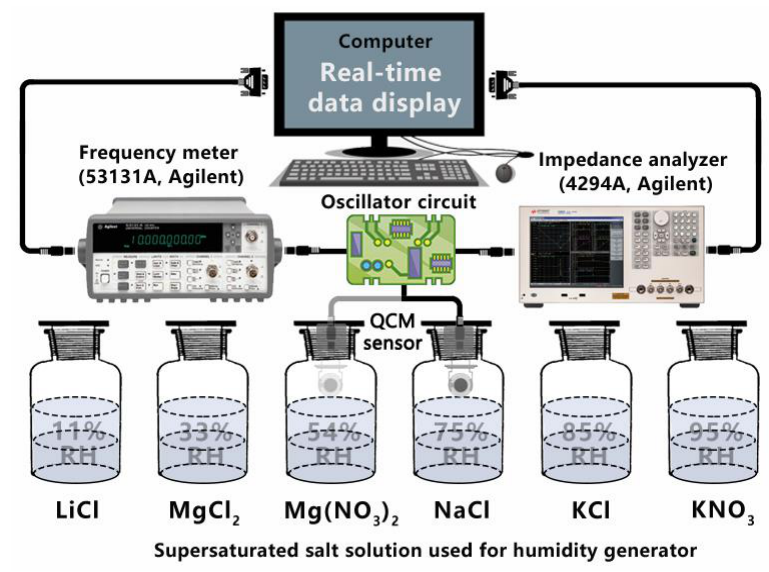
Figure 1. The schematic diagram of QCM sensor humidity detection system.